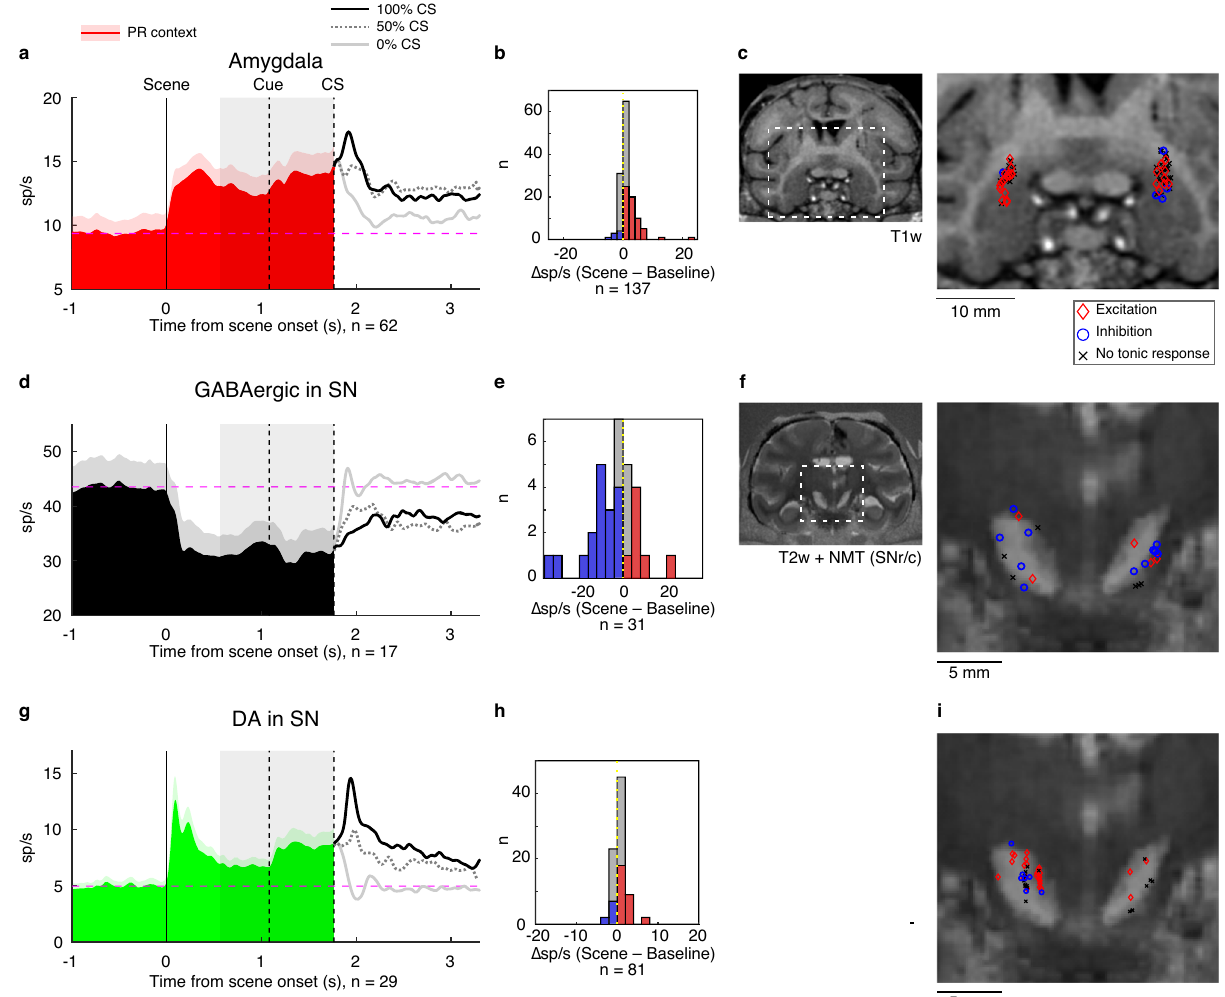
Fig. 5 | Tonic modulation in environmental contexts. a , d , g Population activity for amygdala (excited responses), putative GABAergic (inhibited responses), or putative DA (excited responses) neurons in the Pavlovian task (PR environment). The shaded gray area indicates the spike-count window used to calculate average activities for the tonic component of the scene responses (0 – 1.2s before the CS onset).Tonicexcitation wasshown inmany of amygdala and putative DAneurons. Tonic inhibition was shown in many of putative GABAergic neurons. The shaded red area indicates +1 SEM for the averaged population activity. b , e , h Distribution of responses to PR scene for amygdala, putative GABAergic, and putative DA